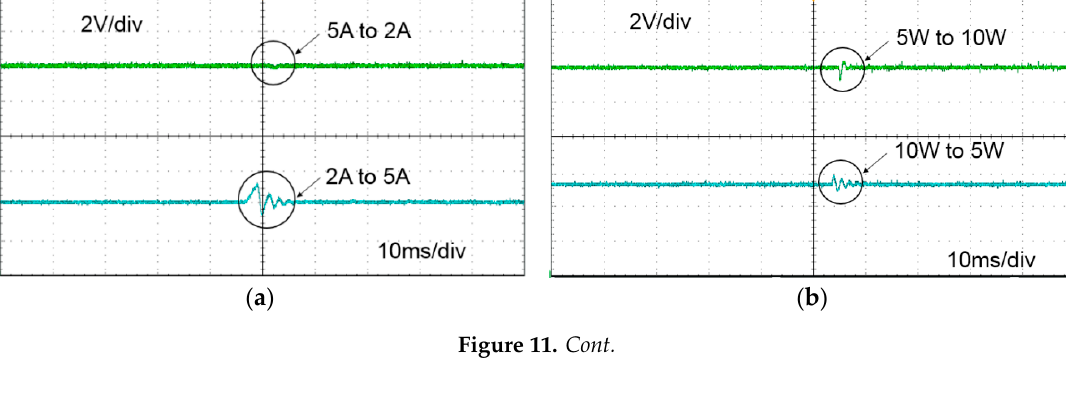
Figure 10. The dynamic voltage and current waveforms of the output diode ( a ) and the inductor ( b ).